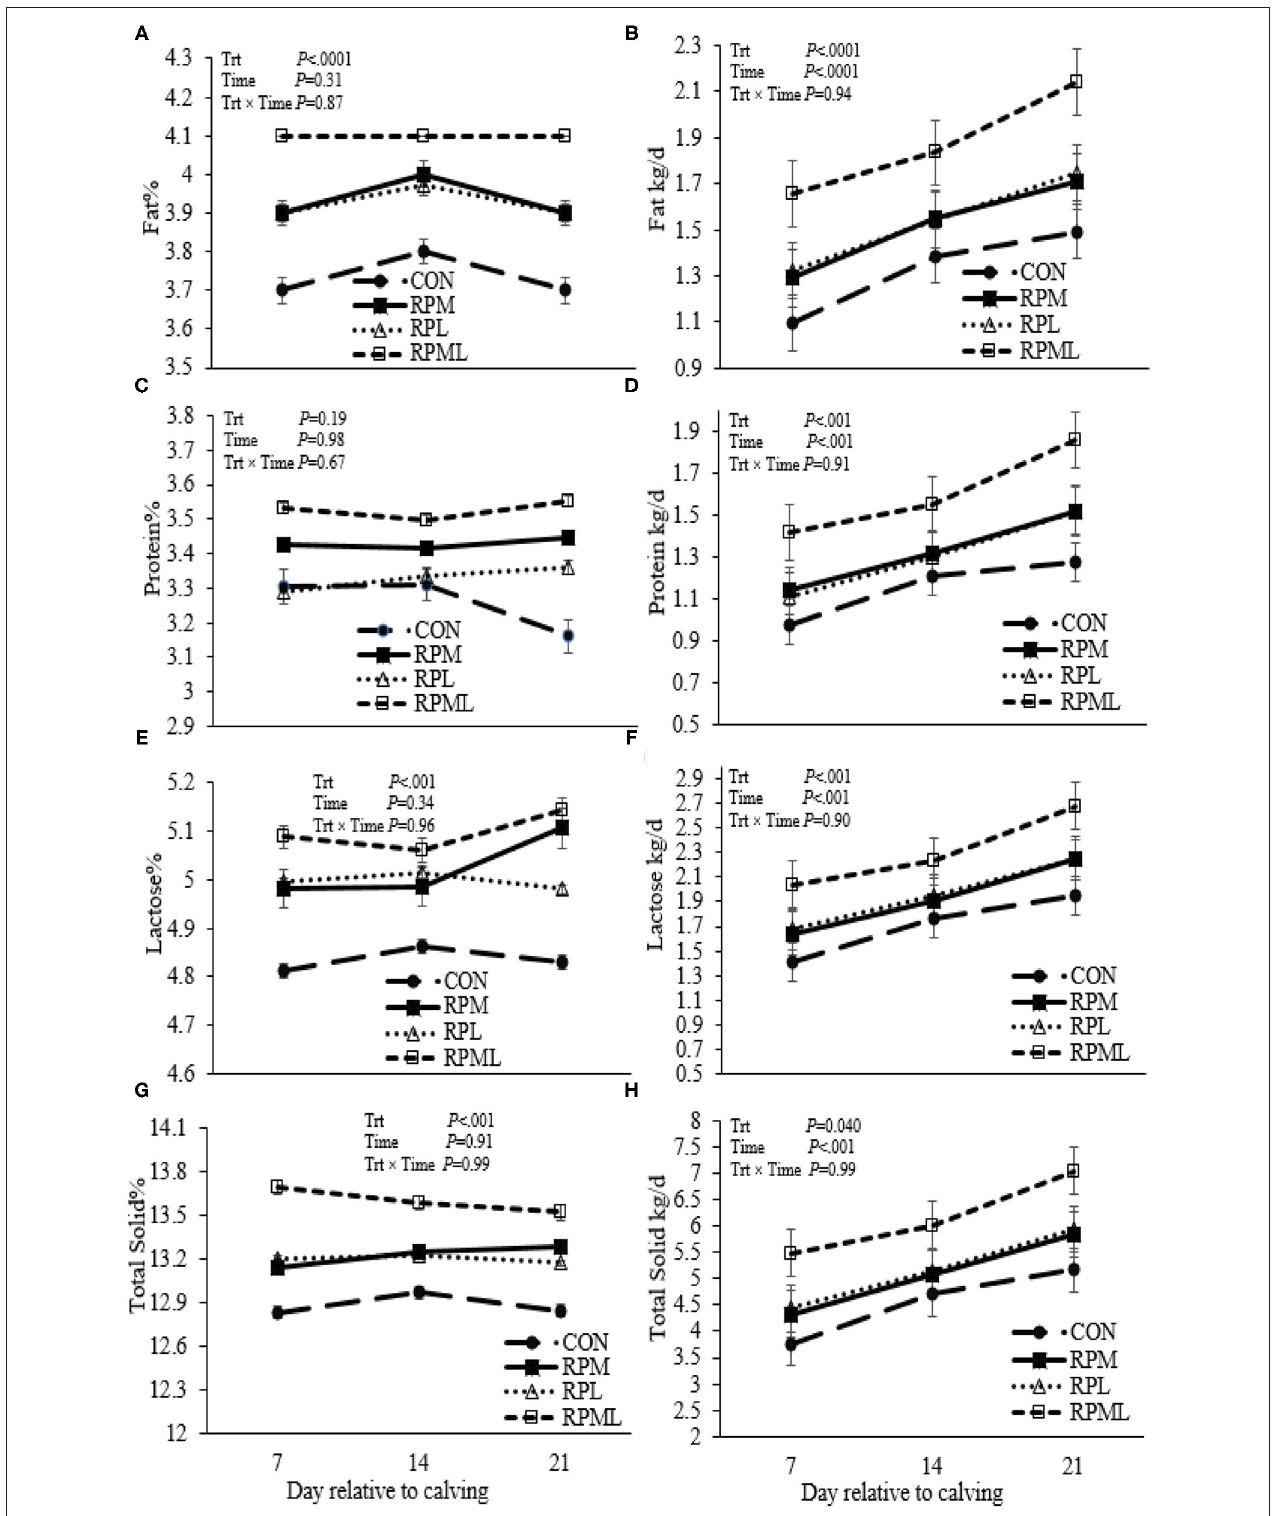
FIGURE 4 | Effect of ruminally protected Lys and Met supplementation on some milk components and yields of Holstein dairy cows during the transition period. Values are means; standard errors are represented by vertical bars.